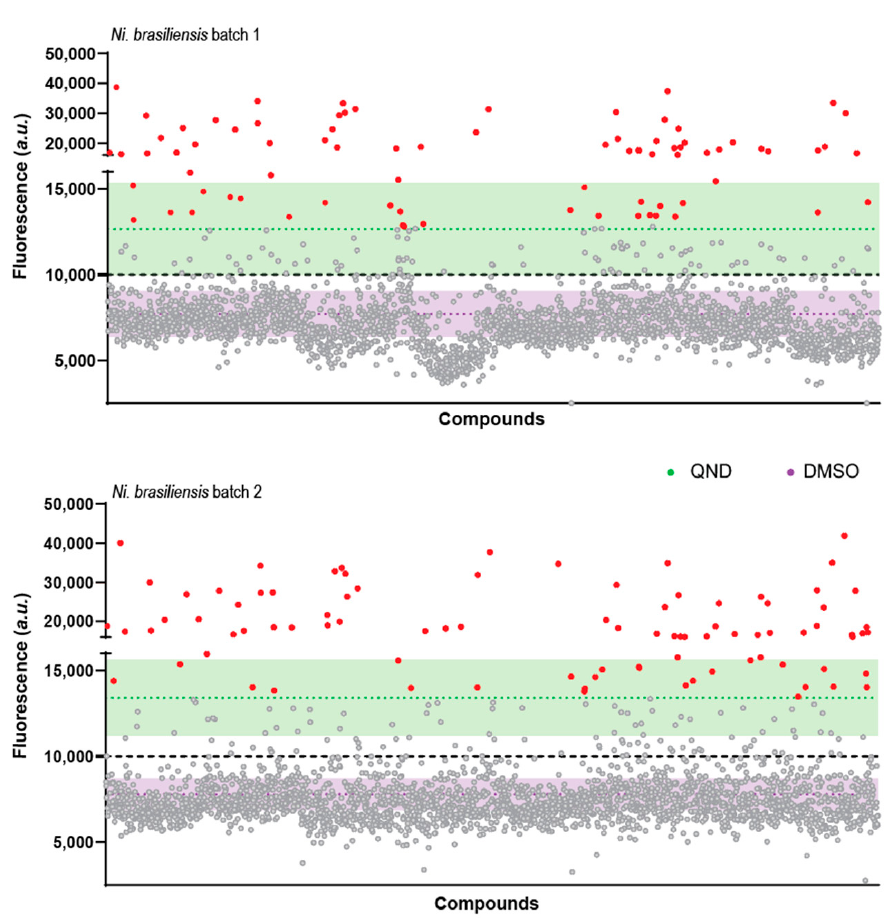
Figure 3. Results of the primary screen of a natural compound library ( n = 2654) against third-stage larvae of Ni. brasiliensis with reference to quinidine as positive control (QND; 32 replicates per plate) and to DMSO 1% as negative control (DMSO, 32 replicates per plate). All compounds were screened in duplicate using different batches of the parasite (top or bottom panel). All values were normalised for each plate to mean (DMSO) + 3 ∗ SD(DMSO) = 10,000 units (Dashed black line). All compounds and positive controls were tested at 100 µ M. Each grey or red dot represents an individual test compound. Mean +/ − standard deviation (dashed coloured line +/ − coloured zone) for controls were calculated as an average of all replicates ( n = 224) and are indicated in green for QND and purple for DMSO. Red dots are hits identified (as described in Figure S1).